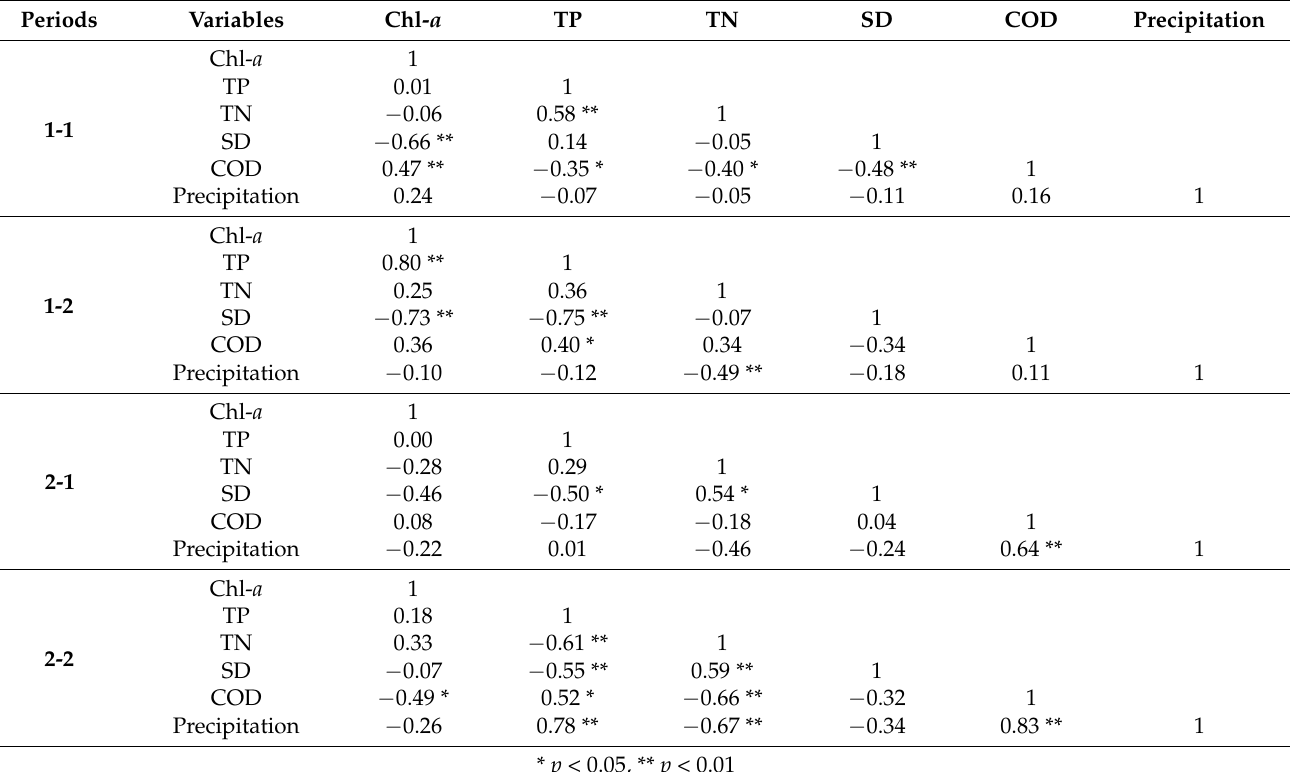
Table 2. Pearson correlation analysis of water quality parameters and precipitation in subperiods in period 1 and 2 (Chl- a : chlorophyll-a, TP: total phosphorus, TN: total nitrogen, SD: Secchi depth, COD: chemical oxygen demand).